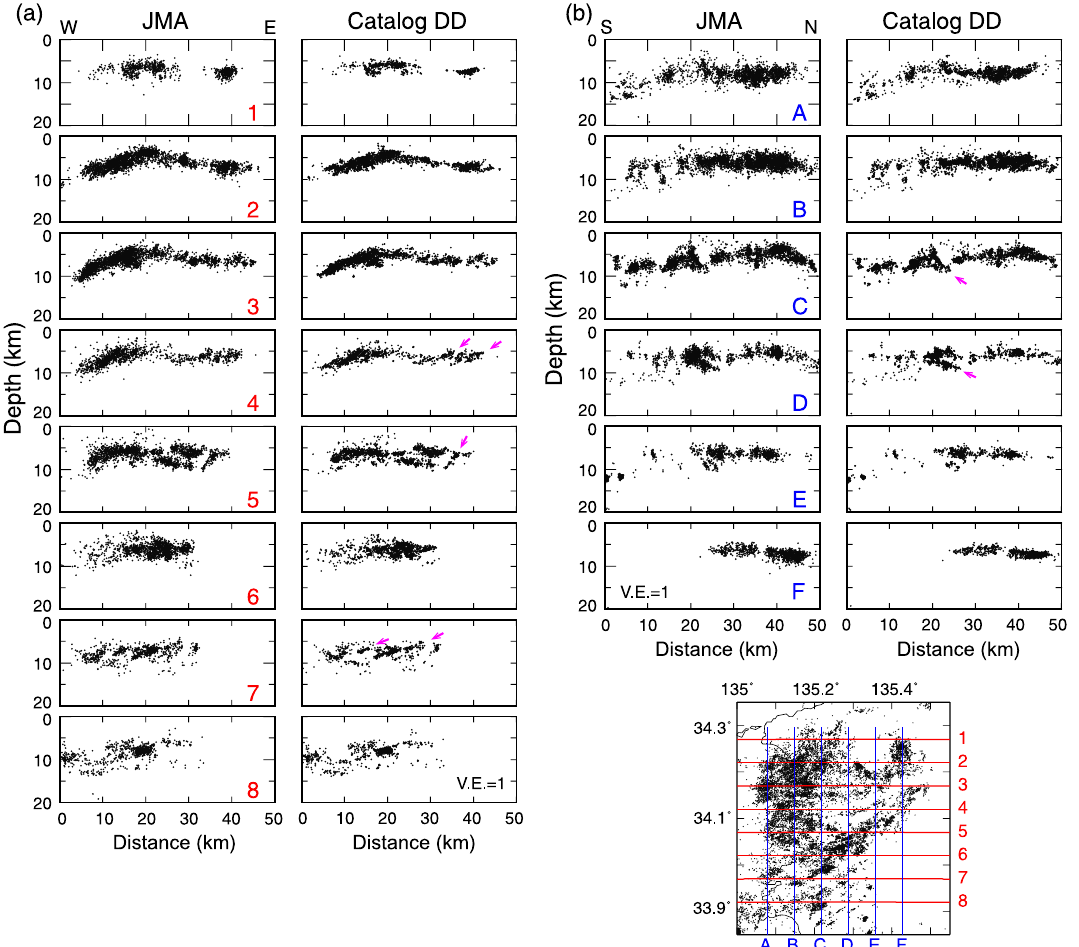
Fig. 7 Vertical cross sections of the (left) JMA hypocenters and (right) relocated hypocenters using the catalog-derived differential time data. a E–W vertical cross sections. b N–S vertical cross sections. Purple arrows denote distinct seismicity dipping northwestward. Profile locations are shown on the inset map. E–W profiles are spaced at a 0.05° (~ 5.5 km) interval, and N–S profiles are spaced at a 0.07° (~ 6.3 km) interval. The earthquakes in each profile do not appear in the adjacent